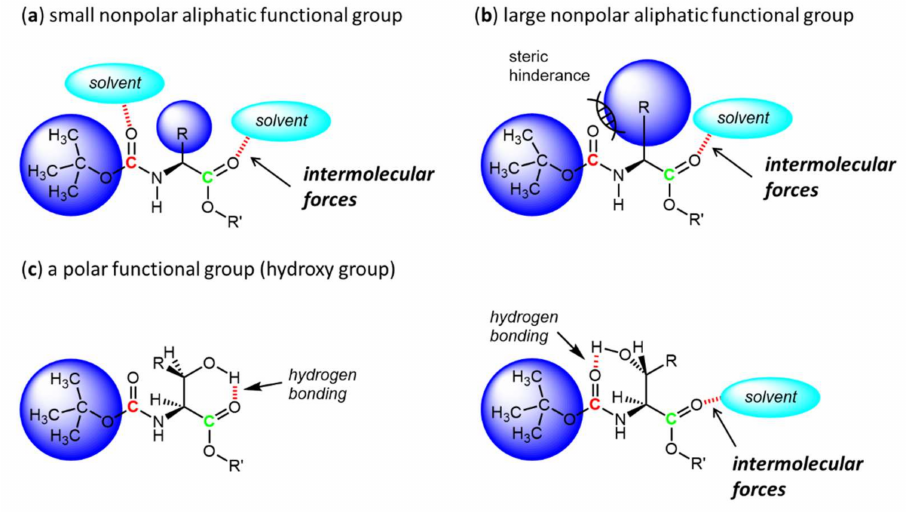
Scheme 2. The existence of intermolecular forces between the carbonyl group in N -Boc-protected amino acid derivatives having several functional groups. ( a ) Small nonpolar aliphatic functional group, ( b ) large nonpolar aliphatic functional group, ( c ) a polar functional group (hydroxy group). Next, we measured 13 C NMR chemical shifts of the carbonyl carbons of five dipeptide derivatives, N -Boc-L-proline-L-alanine-OMe 6 , N -Boc-L-proline-L-serine-OMe 7 , and N - Boc-L-proline-L-proline-OMe 8 , in particular, containing an N -Boc-protected L-proline residue, and N -Boc-L-alanine-L-proline-OMe 9 and N -Boc-L-serine-L-proline-OMe 10 , containing an L-proline methyl ester (Scheme 3). The 13 C NMR chemical shifts of the carbonyl carbons in the N -Boc-protected dipeptide derivatives are listed in Tables S15–S17 (Supplementary Materials). Figures 9–13 show the